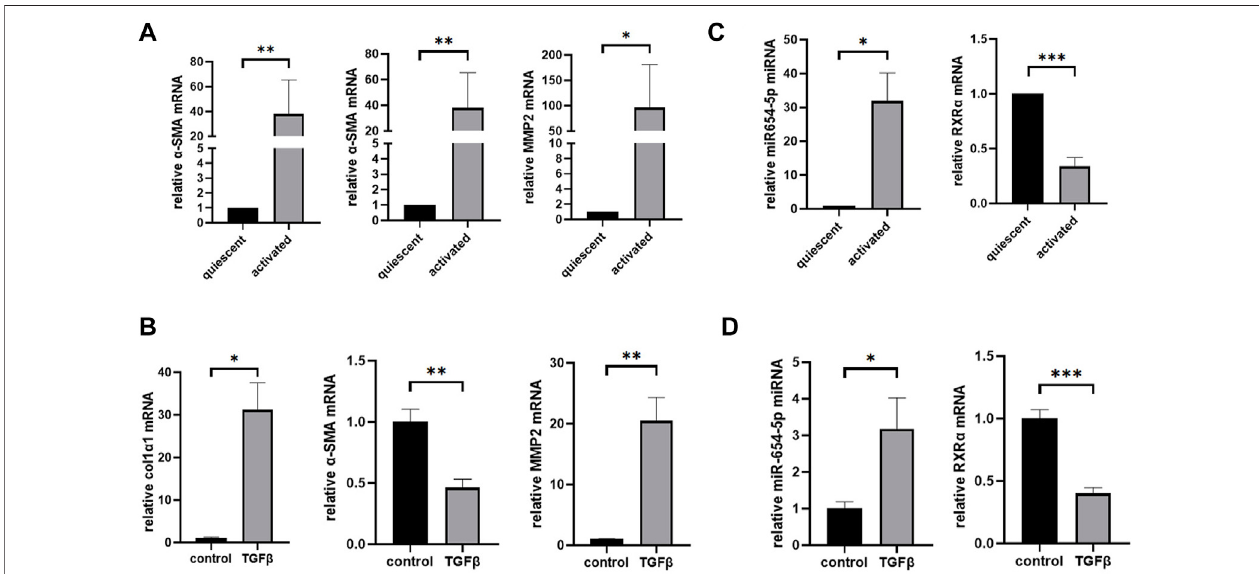
FIGURE 2 | MiR-654-5p expression levels increase while RXR α mRNA expression levels decrease in culture-activated HSCs and TGF β 1-treated LX-2 cells. (A) col1 α 1, α -SMA,andMMP2mRNAexpressionlevelsinculture-activatedHSCsversusquiescentHSCs.Quantitativepolymerasechainreactionanalyseswereperformed to quantify mRNA expression levels with β -actin as a loading control (B) col1 α 1, α -SMA, and MMP2 mRNA expression levels in TGF β 1-treated LX-2 cells versus the controlgroup. (C) MiRNA-654-5p andRXR α expressionlevelsinculture-activated HSCs versusquiescentHSCs. Quantitative polymerase chainreaction analyses were performed to quantify miRNA expression levels with U6 as a loading control (D) MiRNA-654-5p and RXR α expression levels in TGF β 1-treated LX-2 cells versus in the control group. Error bars represent mean ± SEM of at least three experiments. * p < 0.05, ** p < 0.01, *** p < 0.001 and **** p < 0.0001. HSCs, hepatic stellate